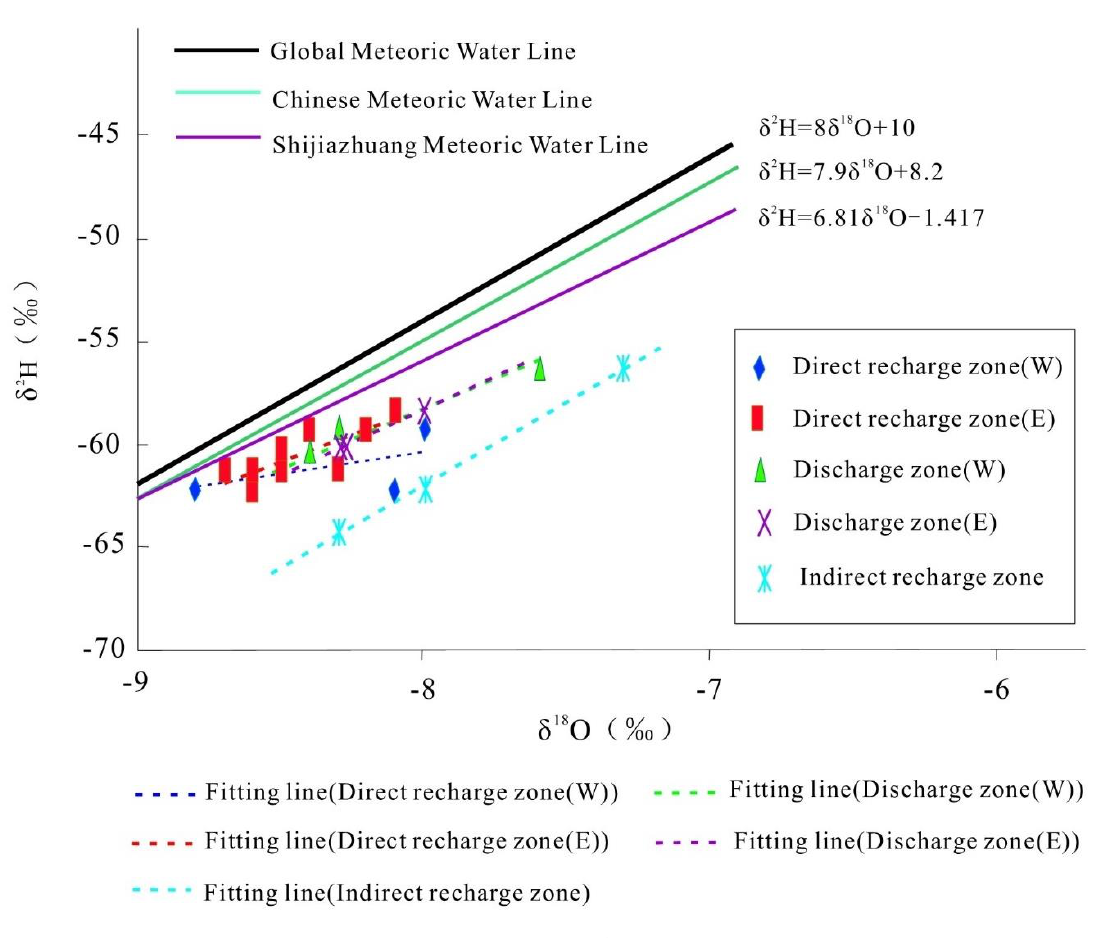
Figure 7. Scatter plots of δ 2 H versus δ 18 O of karst water .